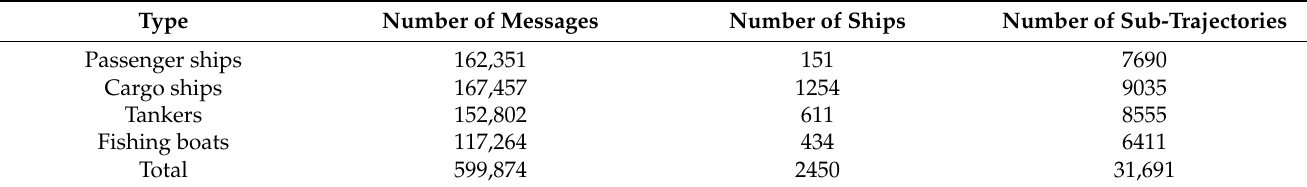
Table 5. The number of dynamic data used in